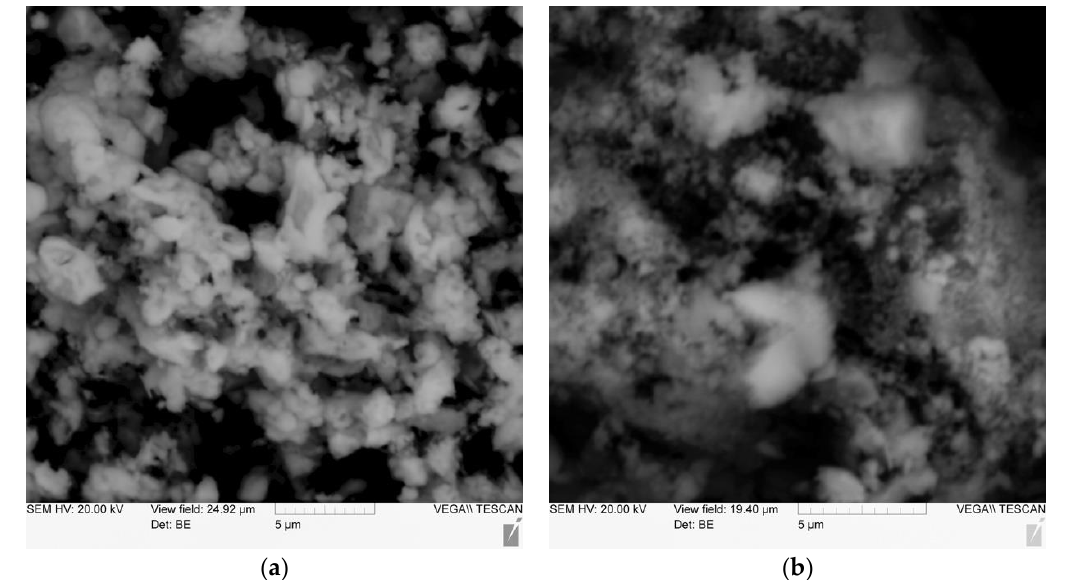
Figure 8. Microcrystals of newly formed calcite in lime mortars: ( a ) splicing of calcite microcrystals; ( b ) rare relatively large crystals of calcite.